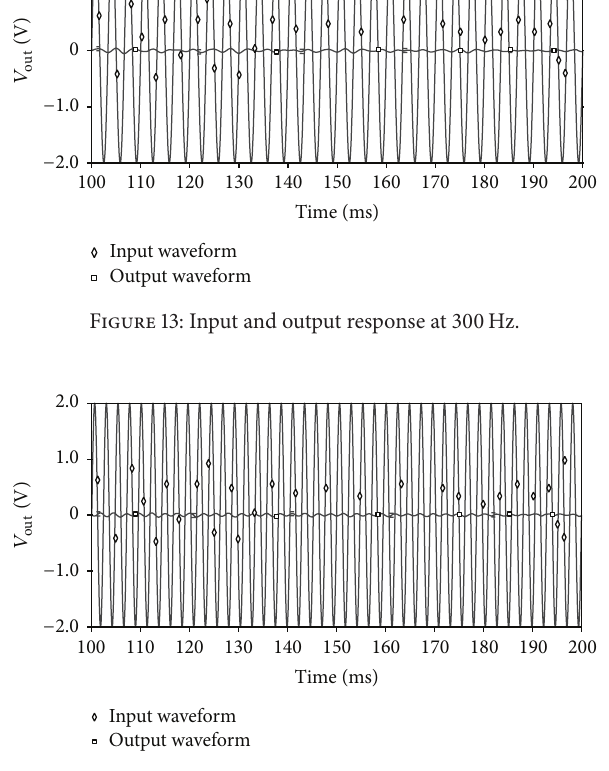
Figure 14: Input and output response at 420 Hz.